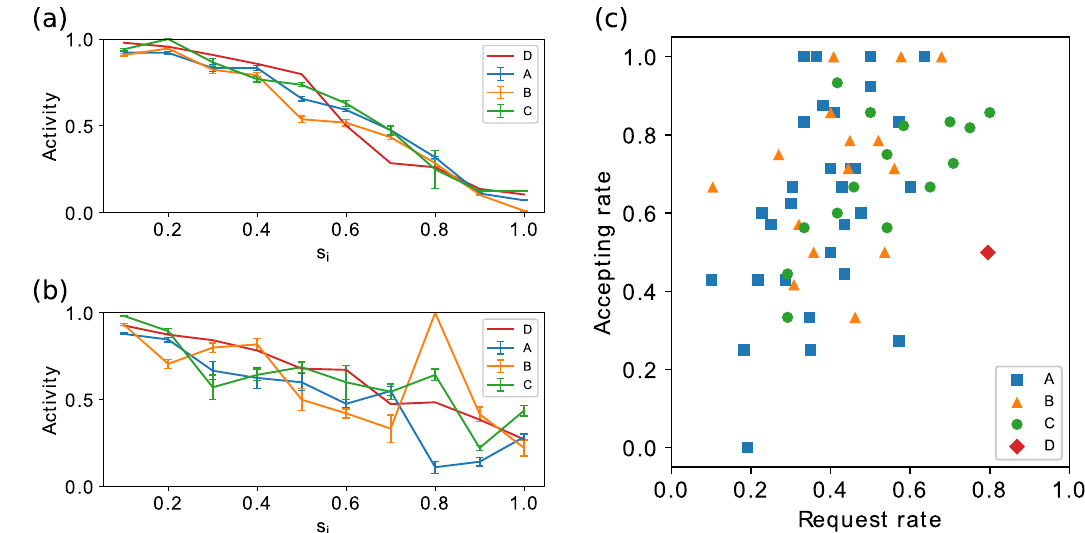
Figure 4. The requesting ( a ) and accepting ( b ) activity of the human players by cluster size in different setups and the autonomous agents’ activity in setup D. All of the setups show a similar decay in activity, but it is notable that the players showed a more relaxed accepting activity in the setups with autonomous agents than in the setup with only human players. This behaviour can be result of the point based rewarding scheme as well as the performance of autonomous agents and their fully cooperative behaviour not resulting in sufficiently large clusters in the hybrid setups. As the autonomous agents were based on the same model, their activity is also represented in the setup D. The points are connected for visualizing the trends and the error bars represent standard error of the mean. ( c ) Overall activity per player in the experimental setups. Each marker represents the fraction of times when a player performed an action having the opportunity to request or accept in a particular setup. The distribution of the markers shows that none of the human players requested a swap in every opportunity they had. It is notable that in a few instances in setups A and B, the player accepted every incoming